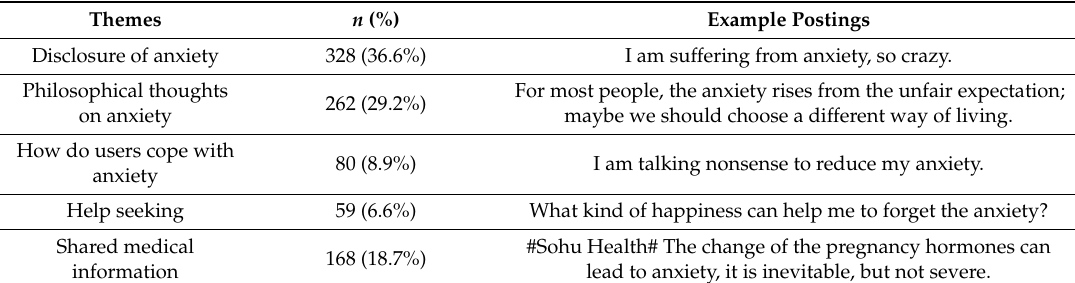
Table 1. Themes of anxiety-related postings.